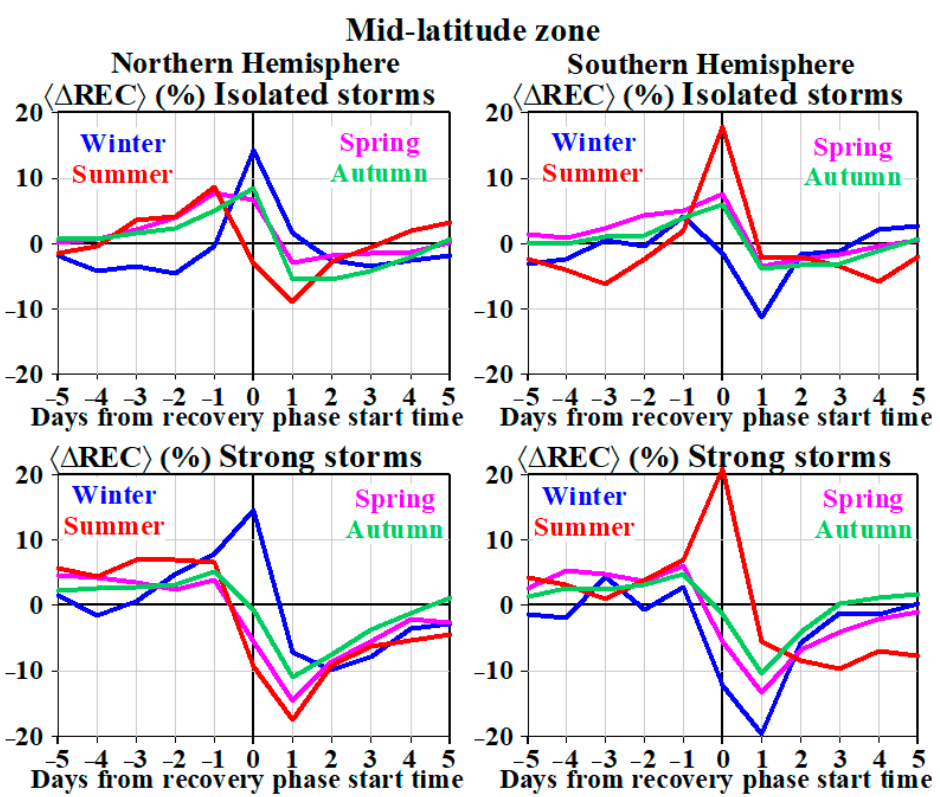
Figure 2. Average response in ∆ REC (‹ ∆ REC ›) as function of day from beginning of geomagnetic storm recovery phase for midlatitude zones of Northern ( left panel ) and Southern ( right panel ) Hemispheres. Upper and lower panels show responses to isolated and strong storms, respectively. Blue, magenta, red, and green curves correspond to winter, spring, summer, and autumn,